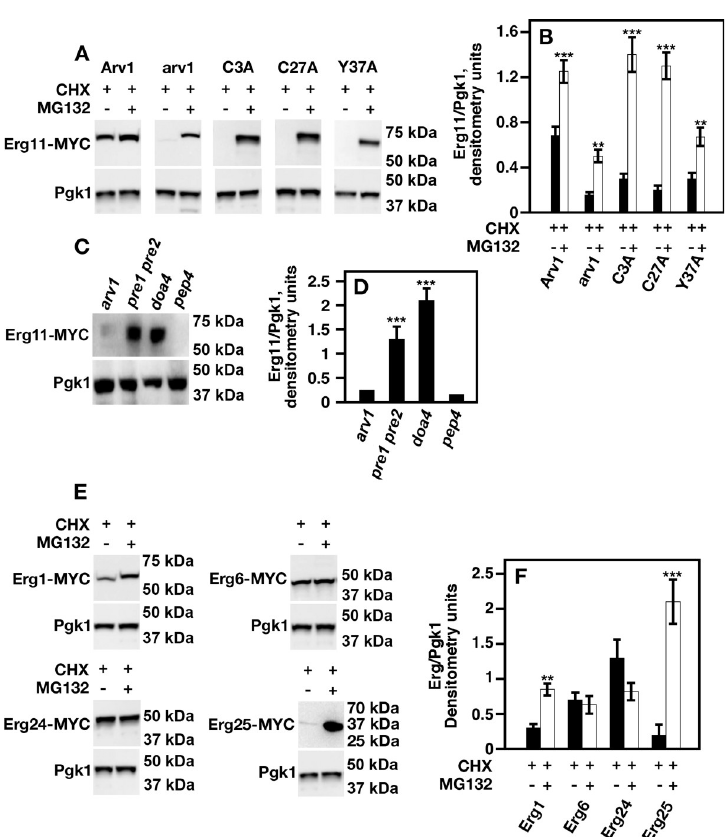
Fig 5. ScErg11 protein level is stabilized in Scarv1 cells expressing ScArv1 C27A in the presence of the proteosome inhibitor, MG132. Cells were treated with cyclohexamide (translation inhibitor) in the absence or presence of MG132 (proteosome inhibitor) for 45 min. ScErg1/6/11/24/25-MYC levels were determined by western analysis using an anti- MYC monoclonal antibody (9E10). ScPgk1 was used as a loading control. (A) ScErg11 levels were determined in cyclohexamide-treated Scarv1 cells expressing Arv1 mutants in the absence and presence of MG132 for 45 min. (B) Relative densitometry units are representative of the data shown in panel A. (C) ScErg11 levels were determined in cells lacking proteosomal chymotrypsin-like activity ( pre1 pre2 ), ubiquitin-dependent degradation ( doa4 ), or carboxypeptidase activity ( pep4 ). (D) Relative densitometry units are representative of the data shown in panel C. (E) ScErg1/6/24/25-MYC levels were determined in cyclohexamide-treated Scarv1 cells in the absence and presence of MG132 for 45 min. (F) Relative densitometry units are representative of the data shown in panel E.